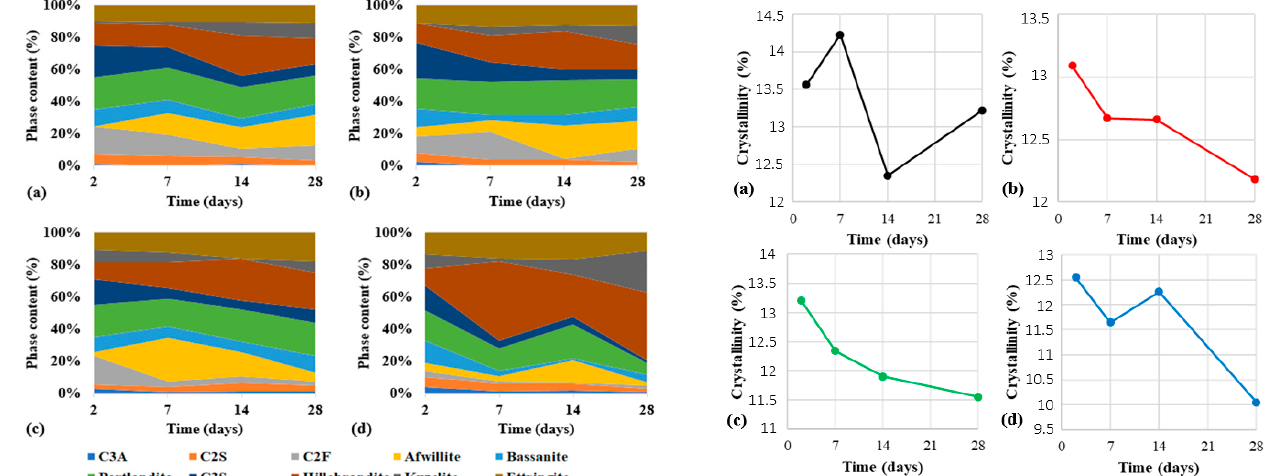
Figure 9. Phase analysis ( left ) and degree of crystallinity ( right ) of C0 ( a ), C15 ( b ), C30 ( c ), and C45 ( d ) samples after 2, 7, 14, and 28 days curing time.